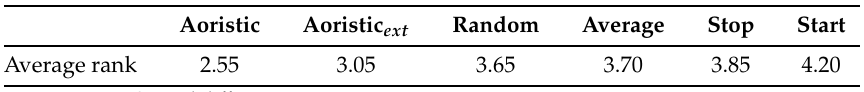
Table 12. Average ranks of the six temporal analysis methods in the temporal resolution of month in the year and with reduced numbers of crimes available during analysis. A lower rank is favorable. Aoristic Aoristic ext Random Average Stop Start Average rank